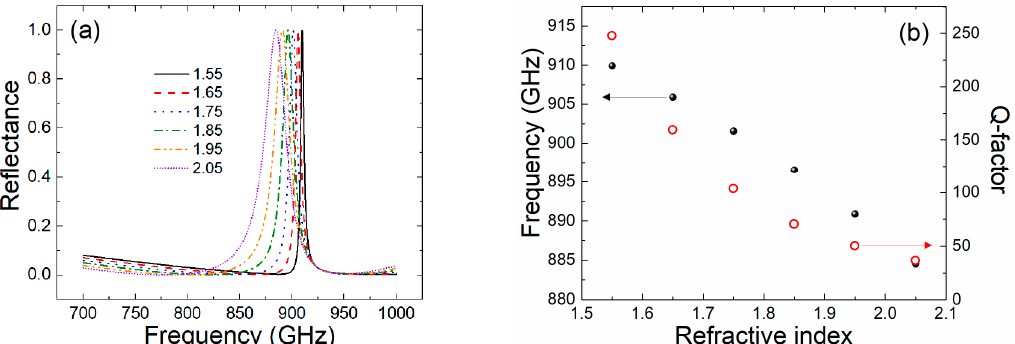
Figure 2. ( a ) Scheme of the simulated THz reflectance with varying refractive index of the grating layer; ( b ) peak frequency and Q-factor for the rectangular pattern, where F = 0.25.